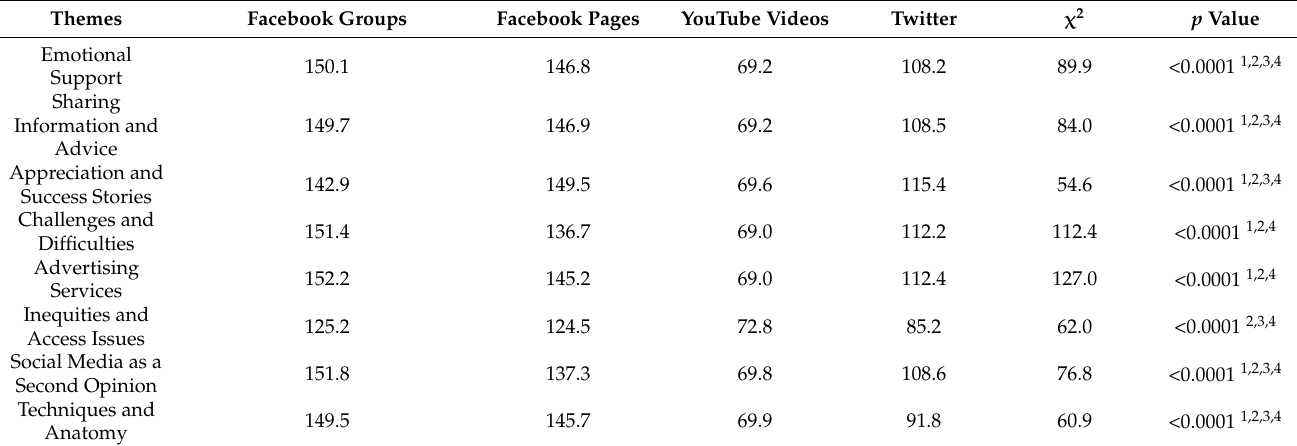
Table 3. Mean rank comparison of the number of comment themes amongst social media